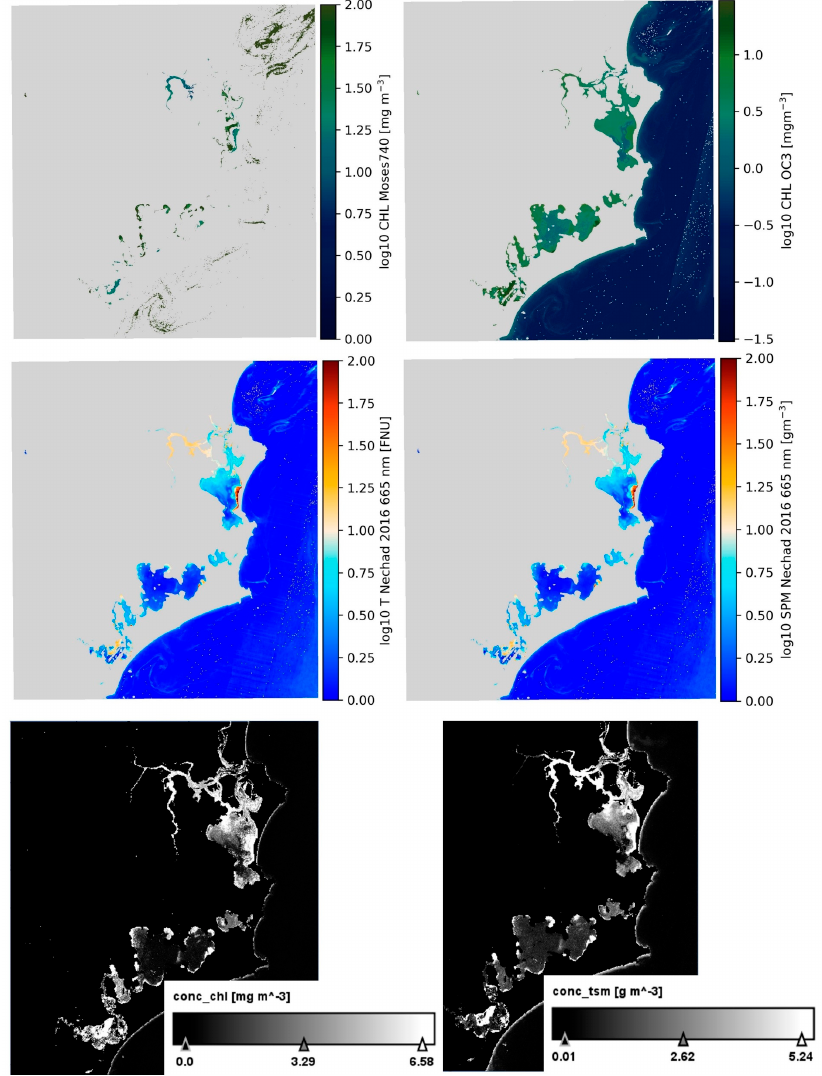
Figure 3. Processed outputs of RS products, from Sentinel-2MSI imagery captured on 22 March 2019. In the top row from left to right are the outputs by the Moses and oceancolor 3, middle row Nechad FNU (turbidity index) and Nechad 2016 suspended matter (spm), in the bottom row C2RCC products chlorophyll a concentration and total suspended matter